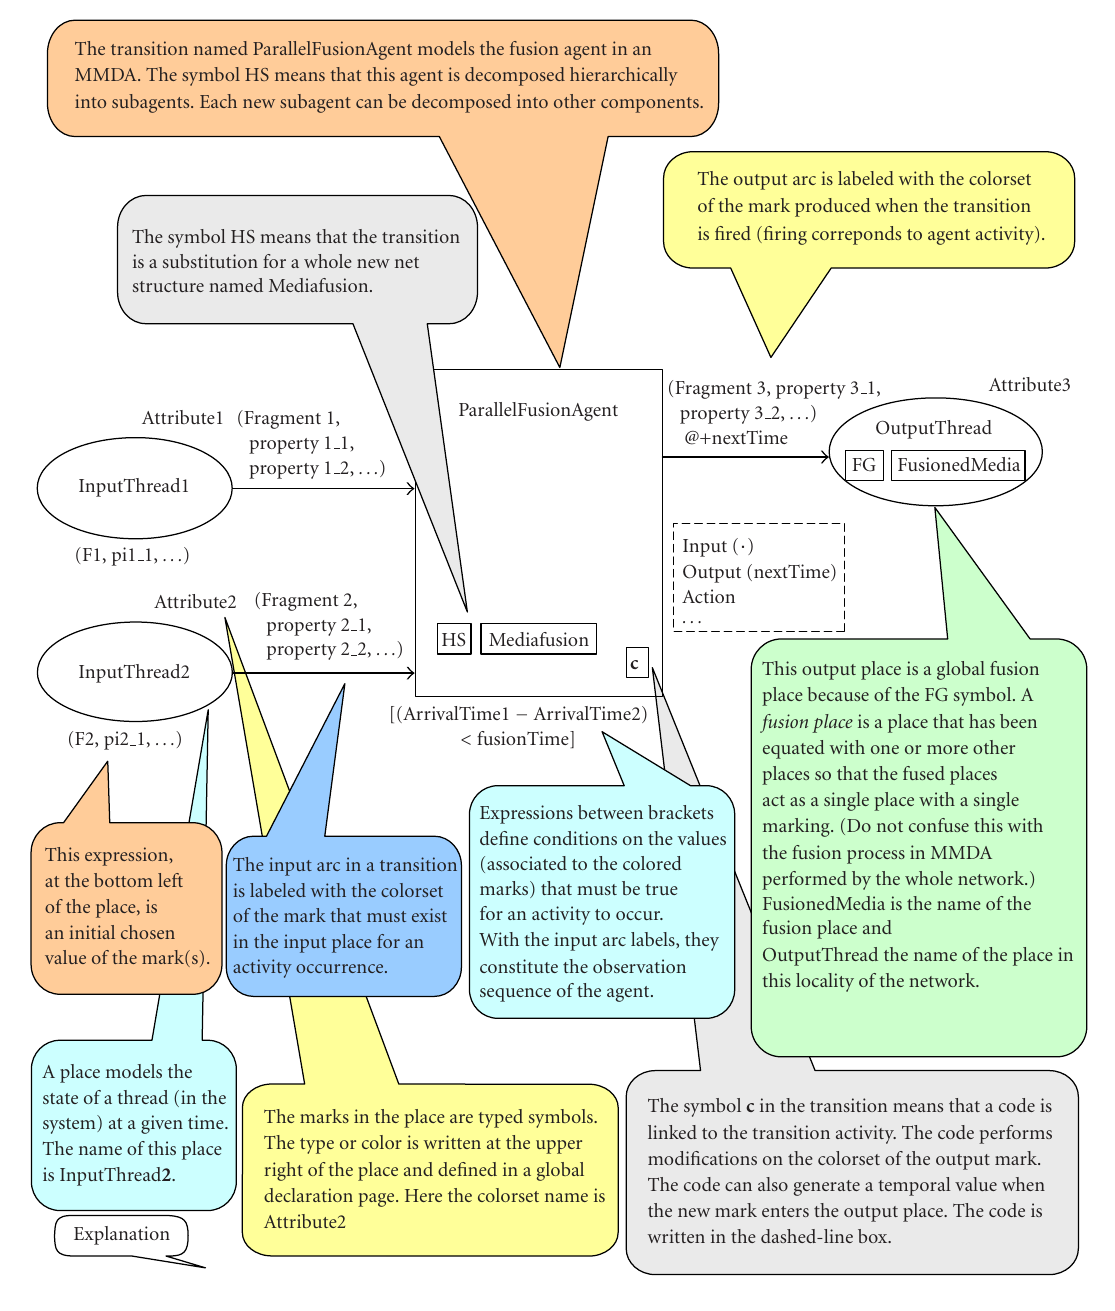
Figure 7: CPN modeling principles of an agent in